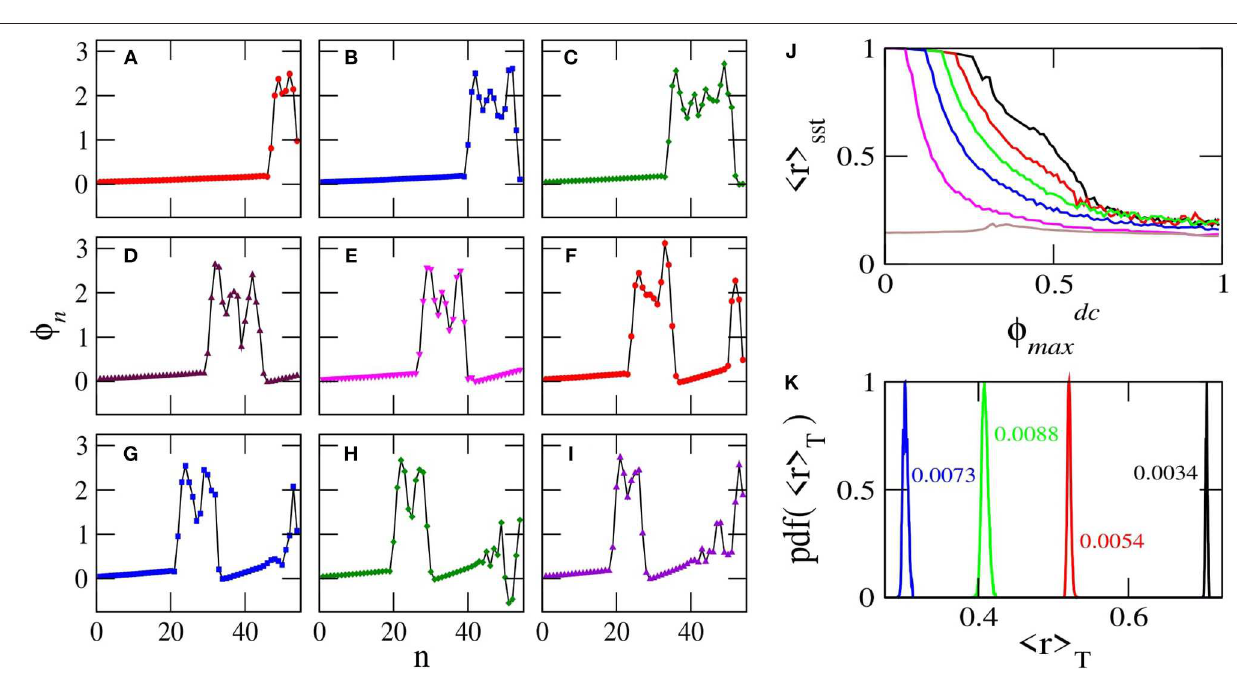
0.86, γ 0.01, λ 0.02, N 54, and (A) (cid:127) = = = − =